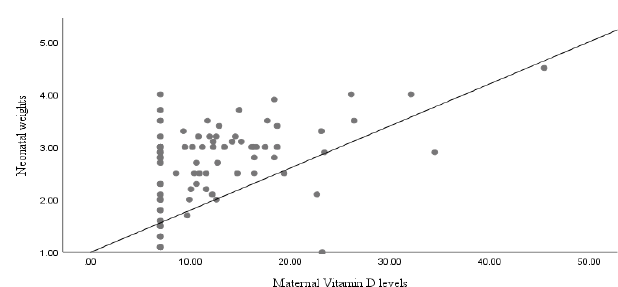
Figure 5 : Correlation between maternal Vitamin D levels and neonatal weights (r = 0.445, p< 0.0001 ((highly